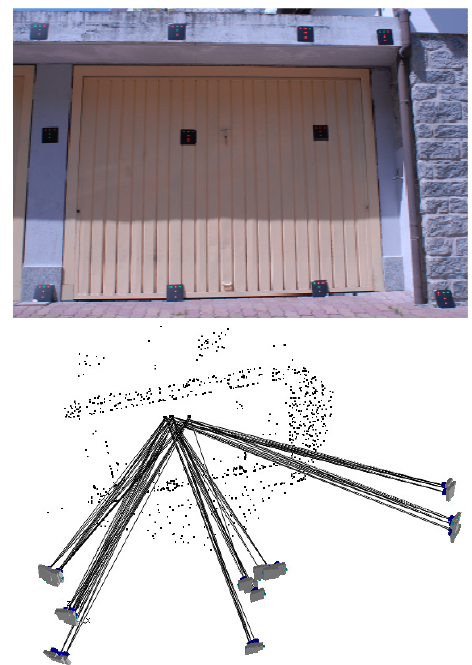
Figure 6. The scene used for the automated camera calibration with and without coded targets (top). The camera network of the targetless solution with the recovered camera poses and sparse point cloud (bottom).